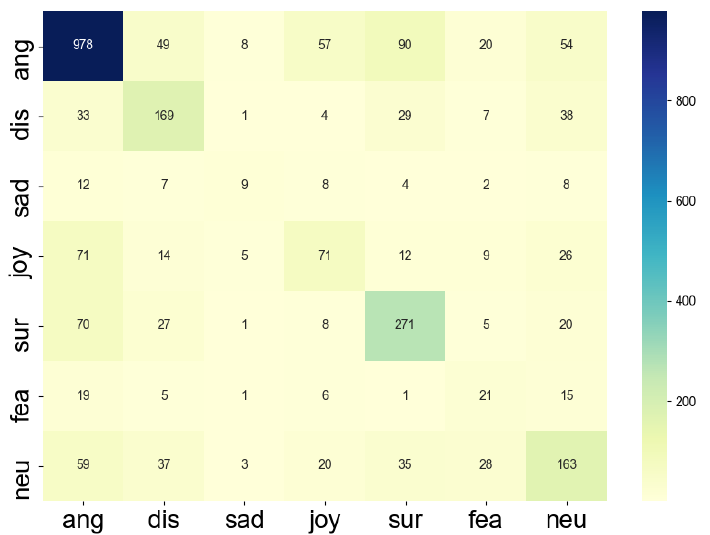
Figure 11. The heatmap of the confusion matrix on MELD dataset; ang = angry, dis = disgusting, sur = surprise, fea = fear, neu = neutral. X-coordinate: model’s prediction and y-coordinate: the ground truth.